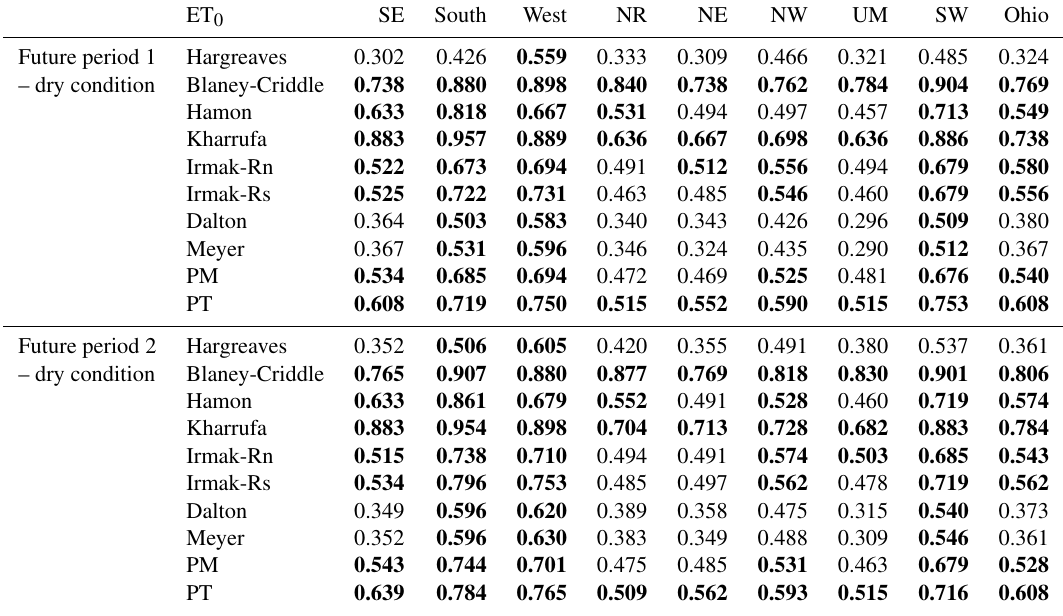
Table 5. The fraction of future dry conditions over all months by the ET 0 estimation method and region (future periods 1 and 2). ET 0 SE